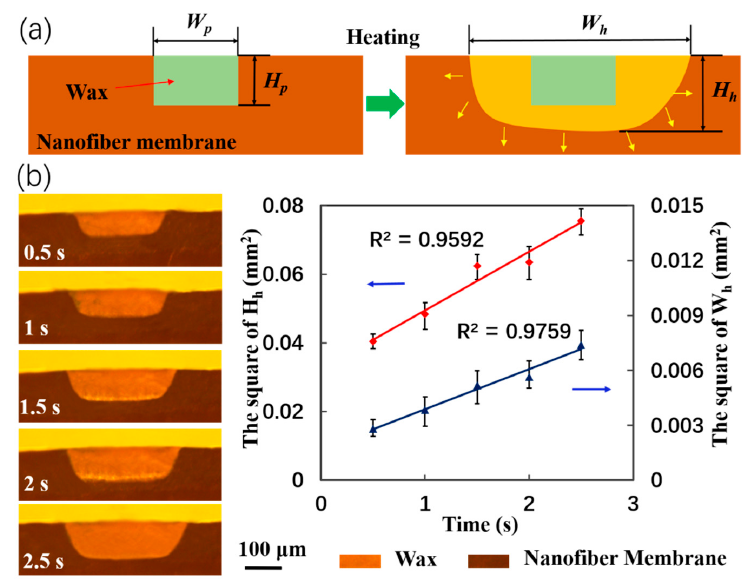
Figure 7. Spreading of wax in a nanofiber membrane. ( a ) Schematic cross-section of wax spreading, where W p and H p are the printed width and depth (green areas), respectively; and W h and H h are the respective values after heating (yellow and green areas). ( b ) Increasing H h and W h in actual images of printed wax with heating time at 120 ◦ C. The values are averages of the barrier widths and